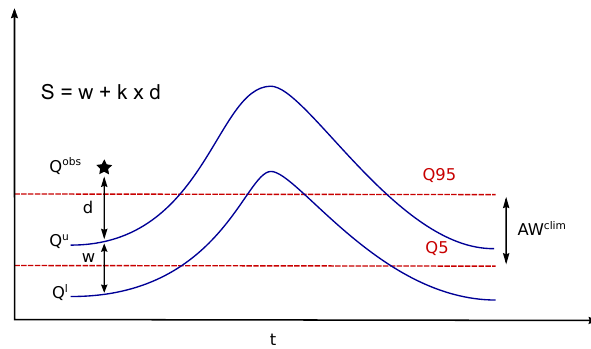
Figure 2. Illustration of the evaluation of the uncertainty bounds. Q 5 and Q 95 are the 5th and 95th percentiles of the flow duration curve. S is the interval score defined at one time step for the situa- tion where the observed value is above the upper limit of the uncer- tainty bound, with k equal to 20 because a 90% interval is given. See the text for further